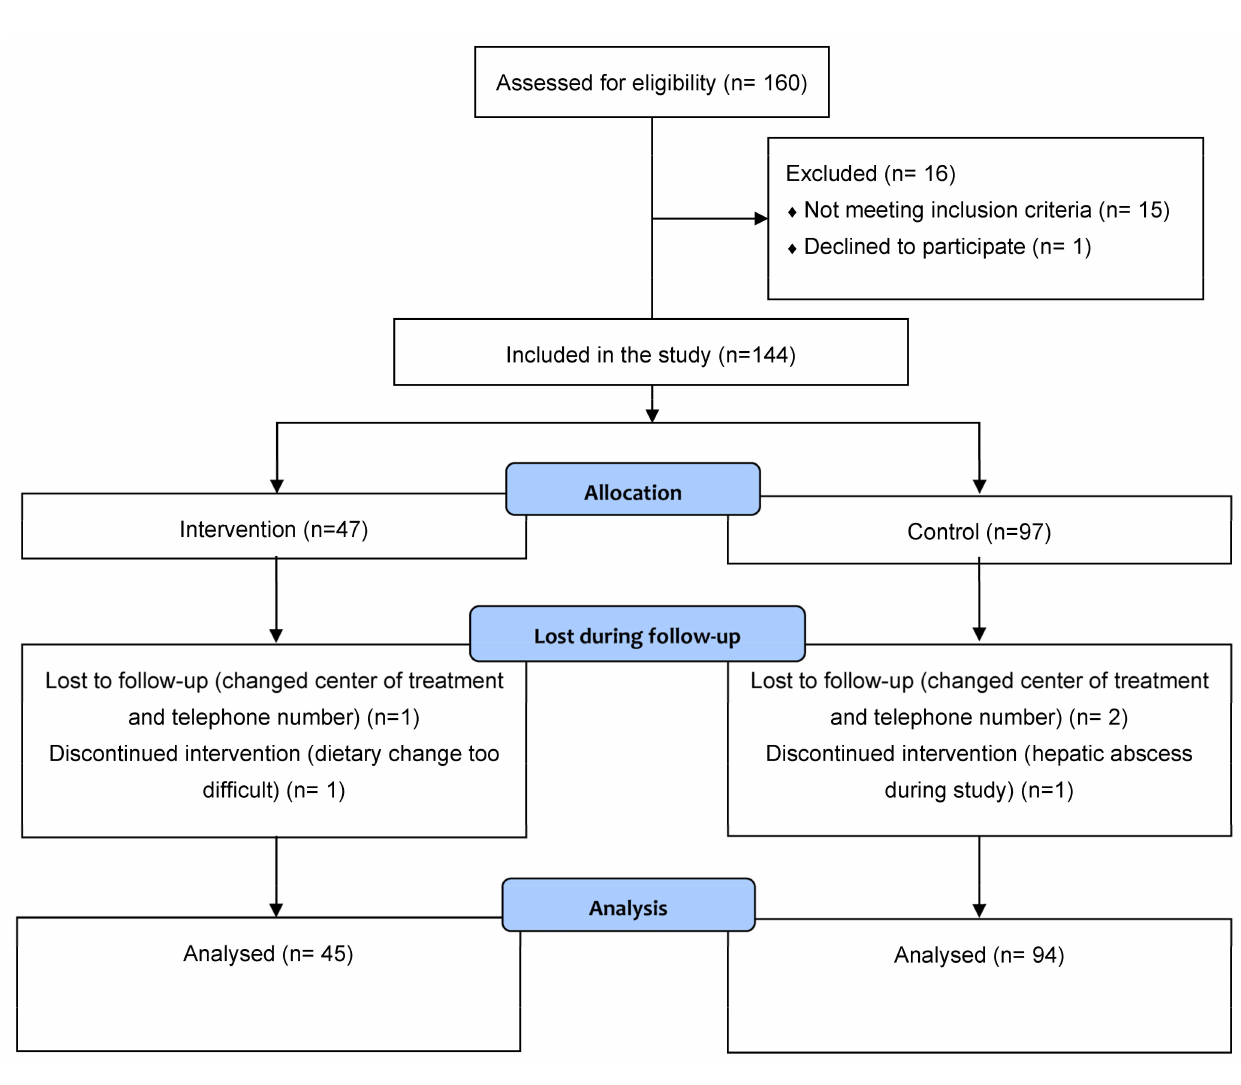
Figure A1. Study design. Table A1. Diet preferences